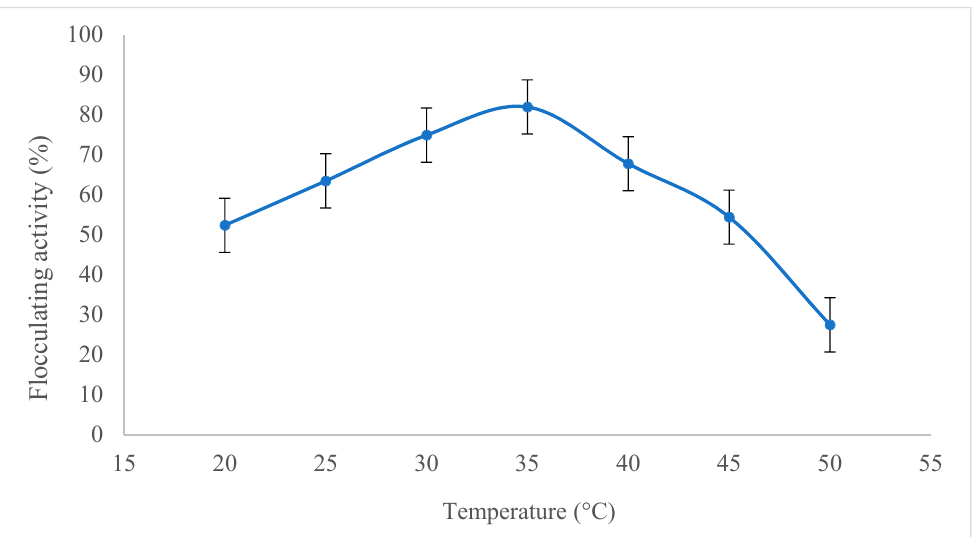
Figure 3. Effect of cultivation temperature on bioflocculant production.